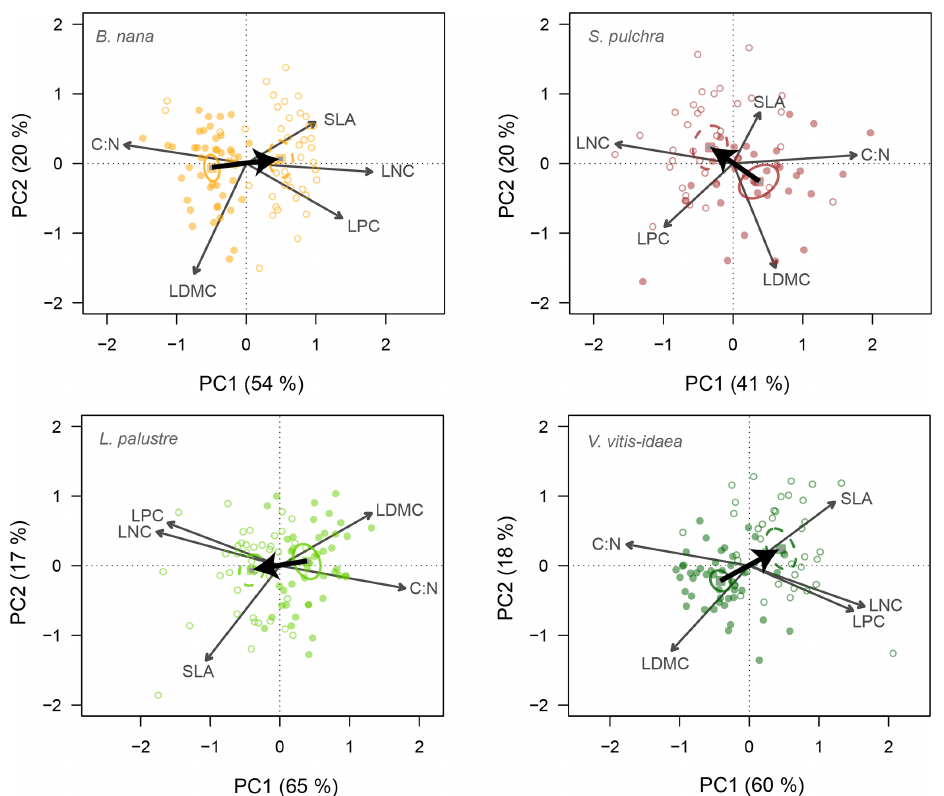
Figure 3. Principal component biplots of leaf traits for each shrub species. Change in leaf traits when nutrients are added is shown by thick black arrows. Leaf traits included in the PCA are leaf dry matter content (LDMC), carbon-to-nitrogen ratio (C : N), leaf nitrogen content (LNC), leaf phosphorus content (LPC) and specific leaf area (SLA). Points are the trait scores of individuals without fertilization (closed circles) and with fertilization (open circles). Sample scores are scaled by a factor of 15, and variable loadings by a factor of 7. Squares indicate the centre of the ordiellipses (standard error with 95% confidence interval) of the trait scores without nutrient addition (solid lines) and with nutrient addition (dashed lines). The total variance explained by the two first principal components (PC1, PC2) is indicated as a percentage between brackets on the